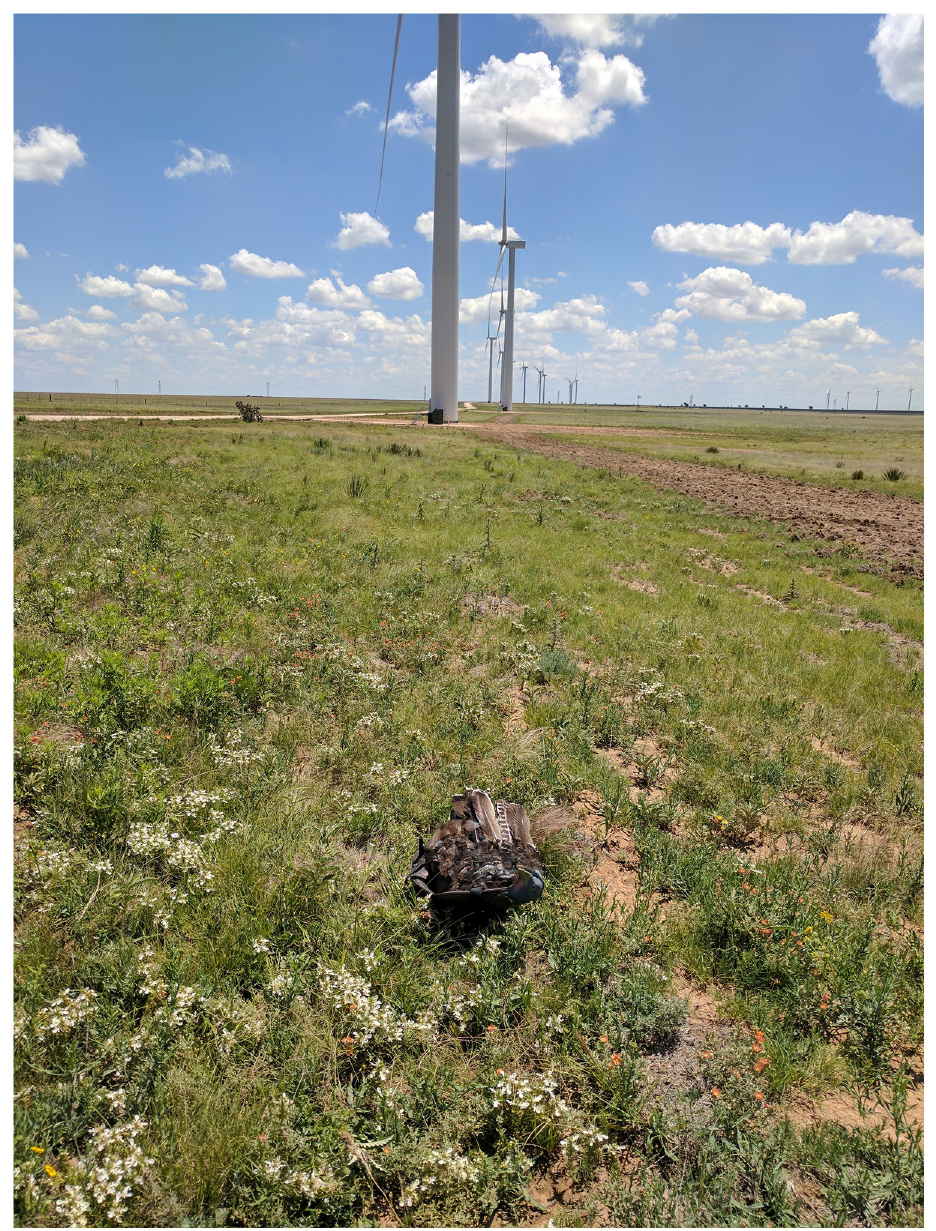
Fig 3. Turkey decoys with feather harnesses were used as a proxy for eagle carcasses during searcher efficiency